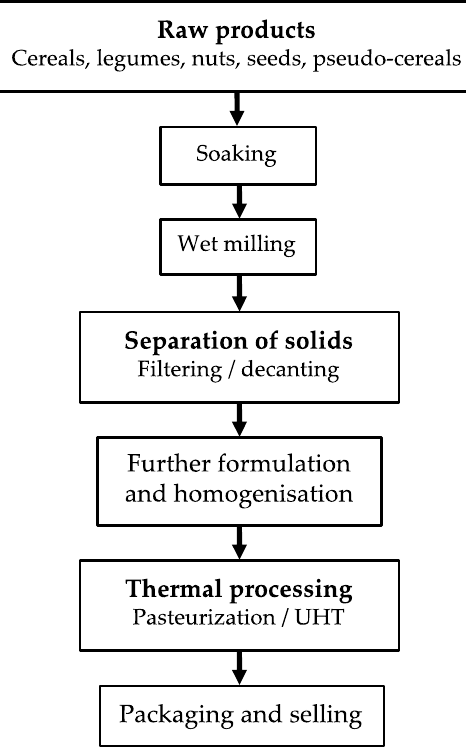
Figure 1. General manufacturing process of plant-based milks starting from raw materials.